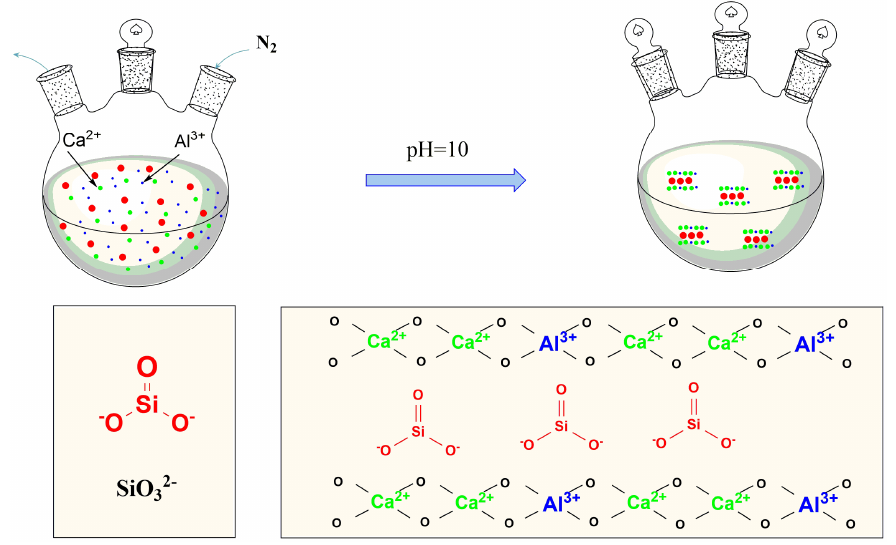
Figure 1. Schematic diagram of synthesis mechanism of CaAl–SiO 3 –LDHs.